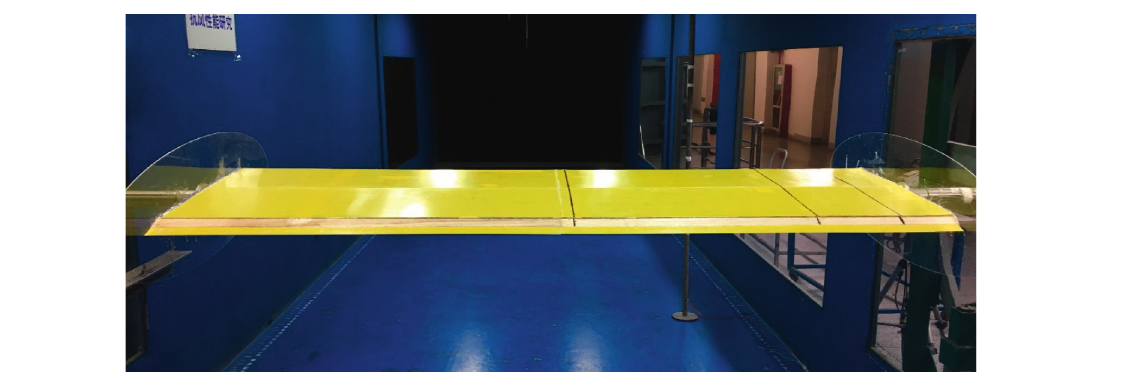
Figure 2: Arrangement of pressure taps.